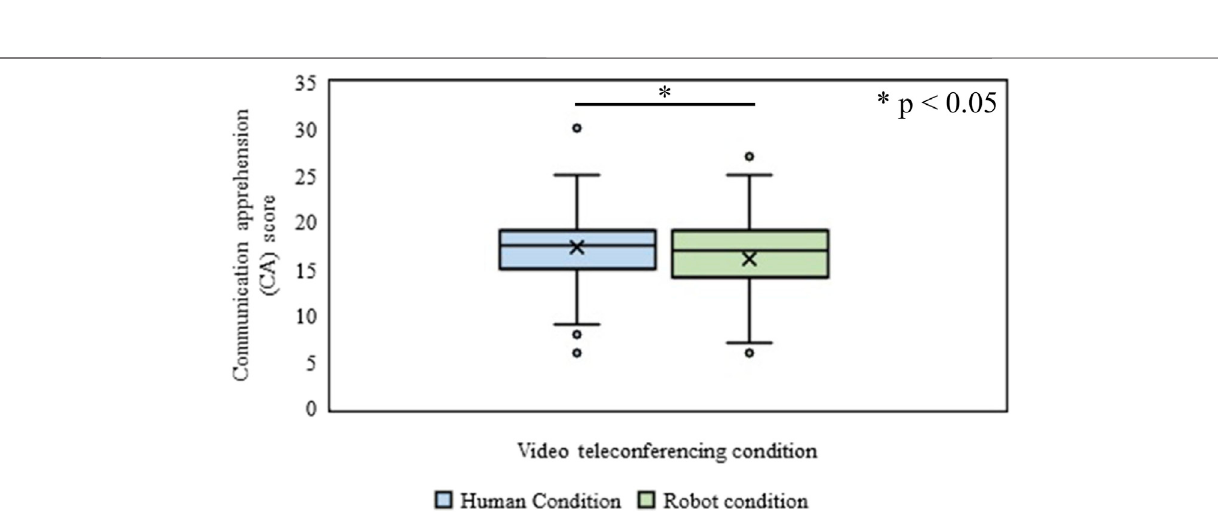
FIGURE 9 | Communication apprehension (CA) in Human and Robot conditions of Experiment- Ⅱ .